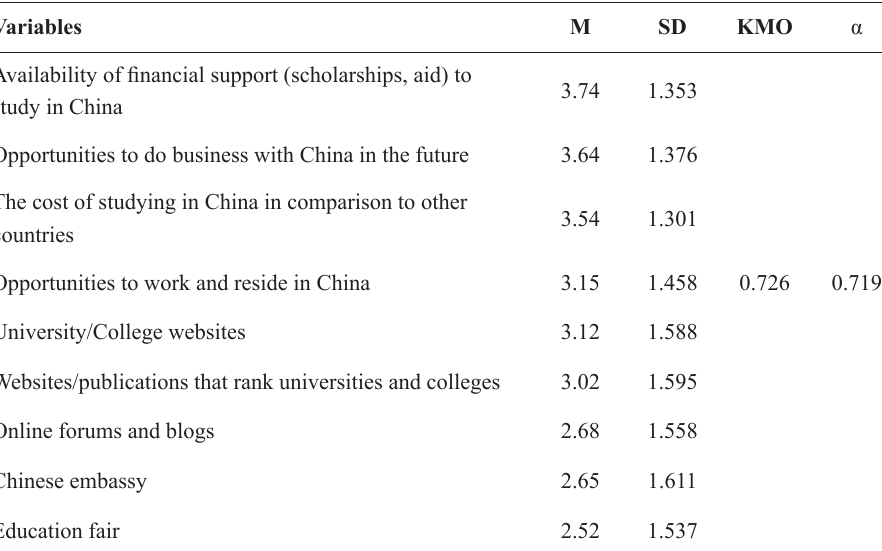
Table 6. African students’ exosystem/socio­cultural